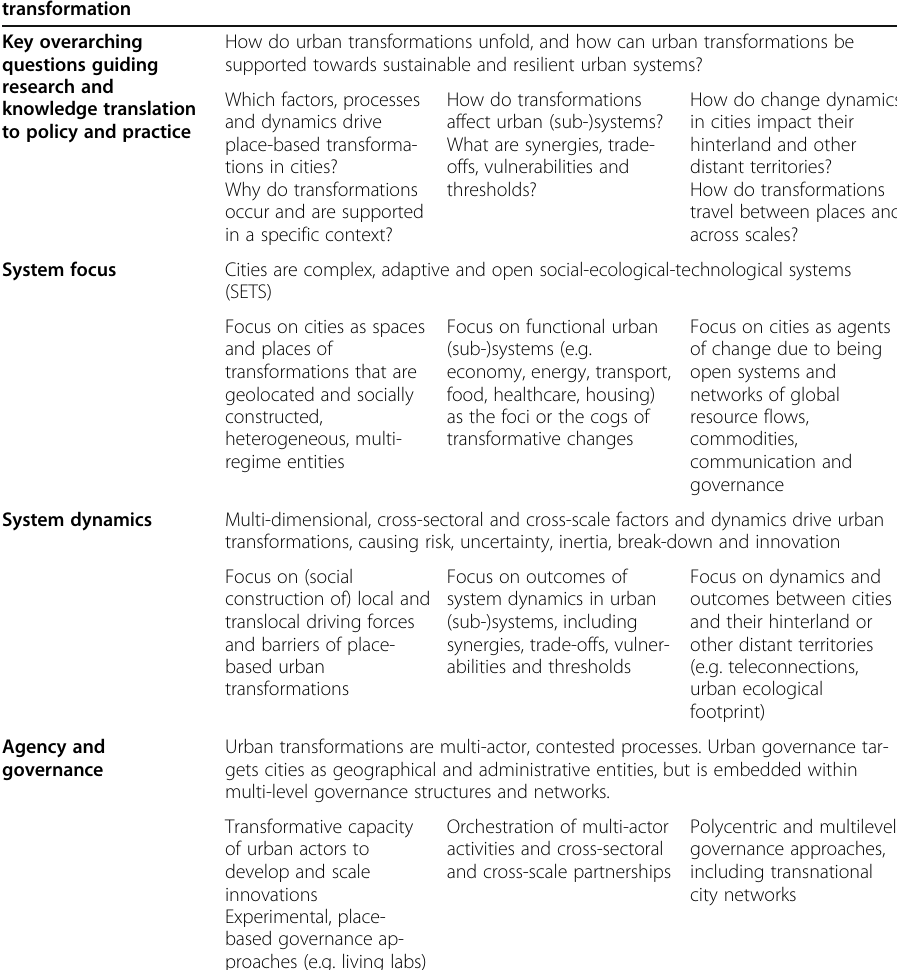
Table 1 Perspectives on urban transformations Descriptor of urban Transformation in cities Transformation of cities Transformation by cities transformation Key overarching questions guiding research and knowledge